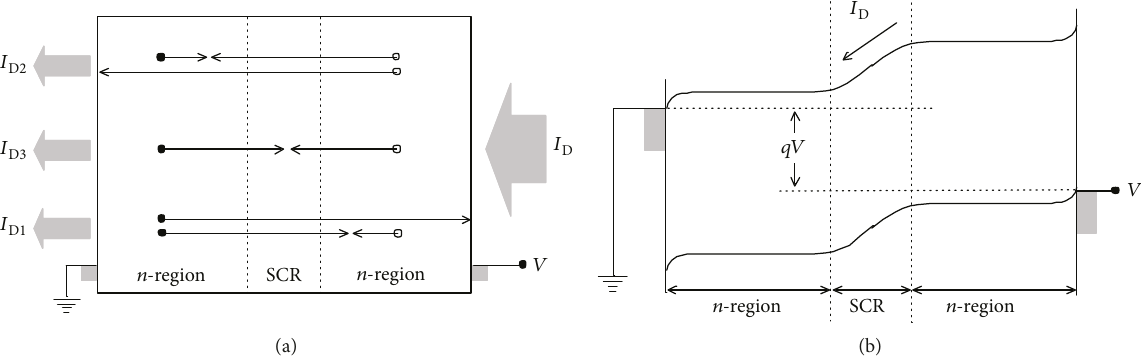
Figure 2: (a) Components of the recombination current in a forward biased p - n junction solar cell [2]. (b) Energy band diagram of a forward biased p - n junction corresponding to Figure 2(a).